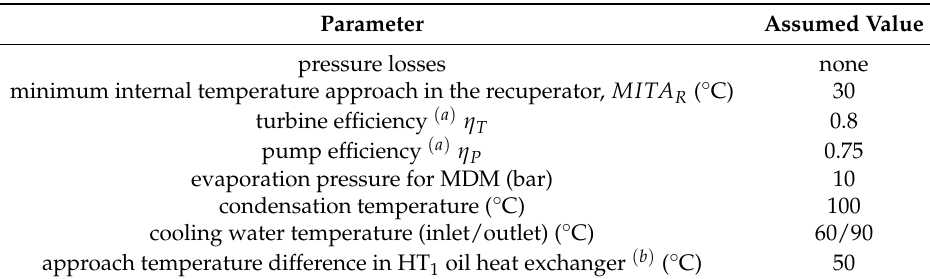
Table 2. Design parameters assumed for the calculations.